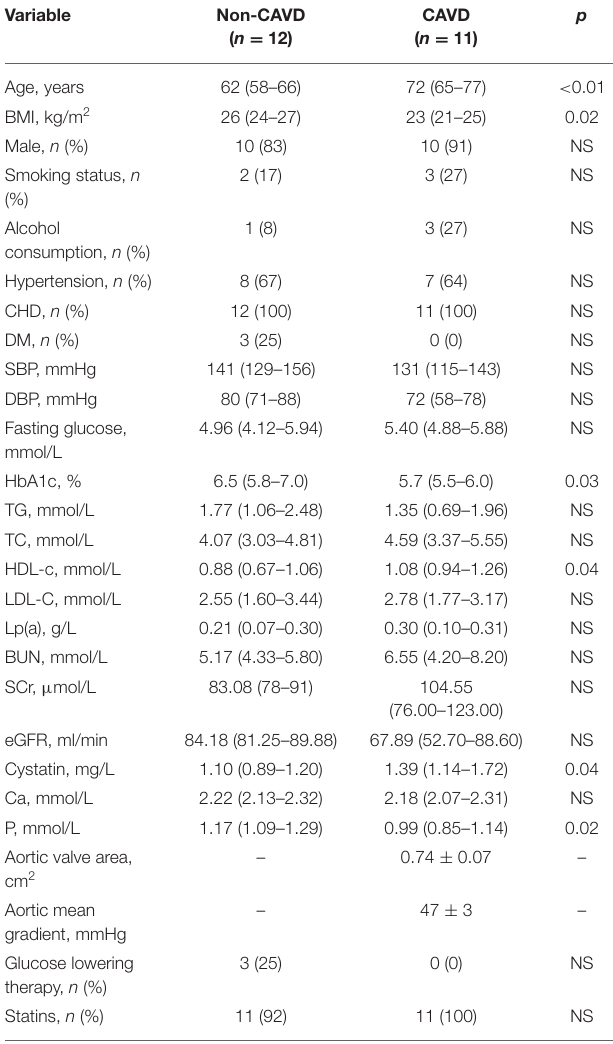
TABLE 1 | Baseline characteristics of aortic valves obtained from